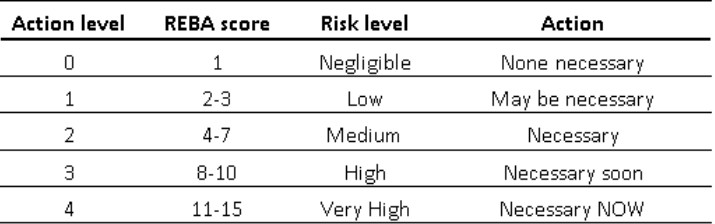
Table 1 . REBA action